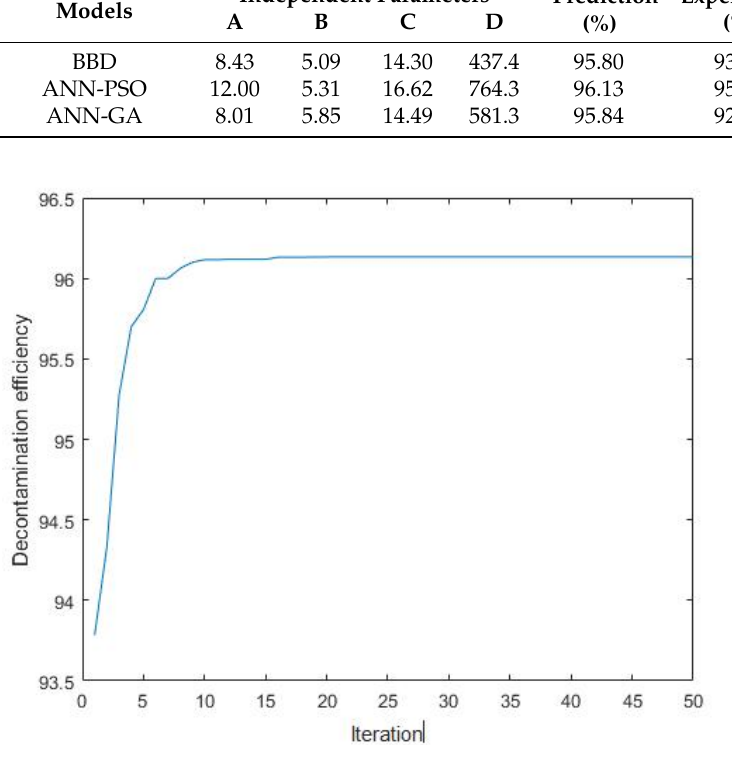
Figure 25. Decontamination efficiency versus iteration.